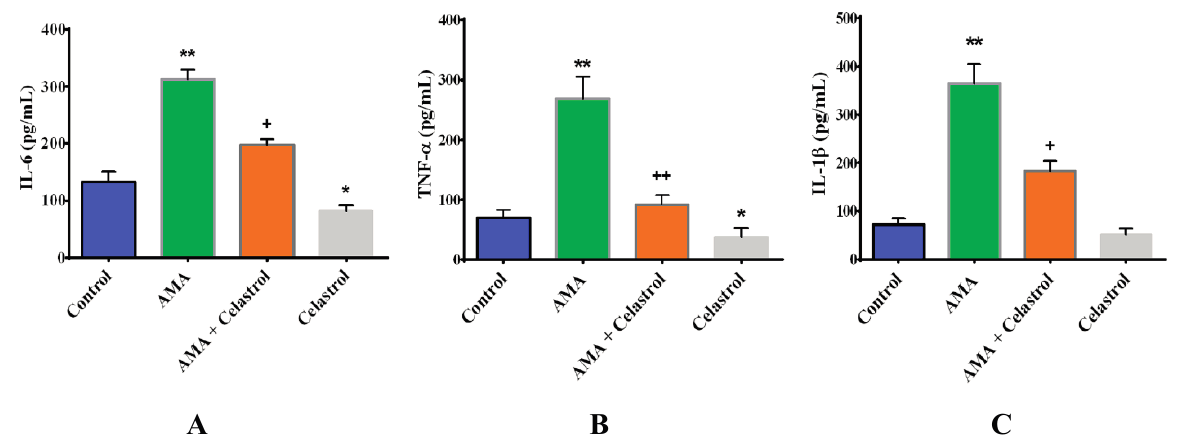
Figure 6. Effects of AMA and celastrol on the production of pro-inflammatory cytokines with regard to mitochondrial-induced insulin resistance in human myotubes. Cells were incubated for 48 h with DMSO (control), AMA, celastrol-AMA and celastrol only. The quantification of IL-6 ( A ), TNF- α ( B ) and IL-1 β ( C ) was determined as briefly described in materials and methods. Values are normalized against standard curves generated according to standard protocols provided by manufacturers. * p < 0.05 and ** p < 0.01 vs . untreated control; + p < 0.05 and ++ p < 0.01 vs . AMA-treated